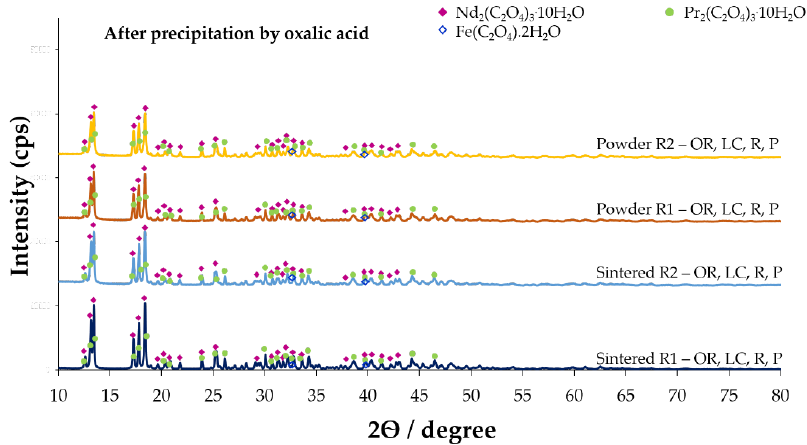
Figure 11. The XRD analyses of neodymium oxalates obtained from route I: oxidative roasting and selective-leaching, and route II: whole leaching. Note: OR: oxidative roasting, LC: leaching, R: roasting and P: precipitation.